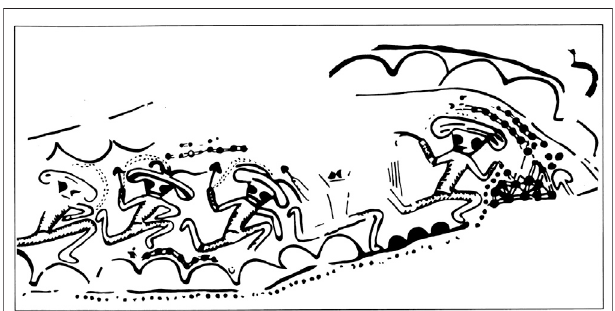
FIGURE 1 | Mushroom Dancers. Relief of a painting in a rockshelter of Tin TazariJt, Tassili, Algeria with dancing fi gures with a mushroom as a head andamushroom-likeobjectintherighthand(fromSamorini,1992).Estimated to be 7000-9000 years old. (Photo credit: Giorgio Samorini; used with